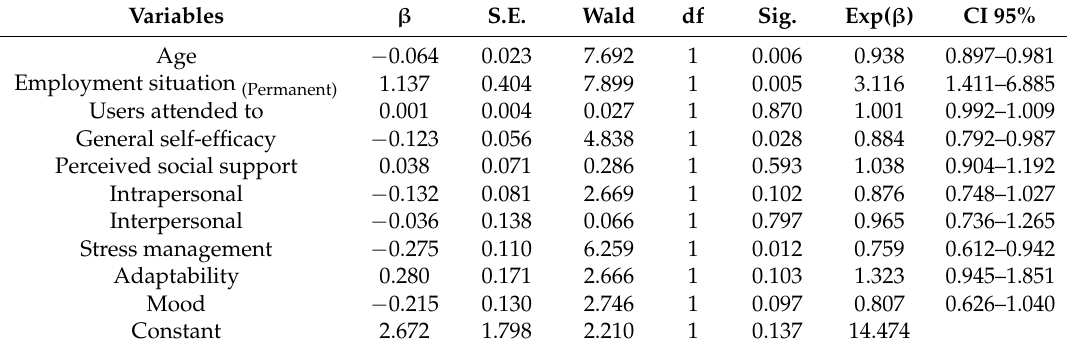
Table 2. Results derived from the logistic regression for probability of